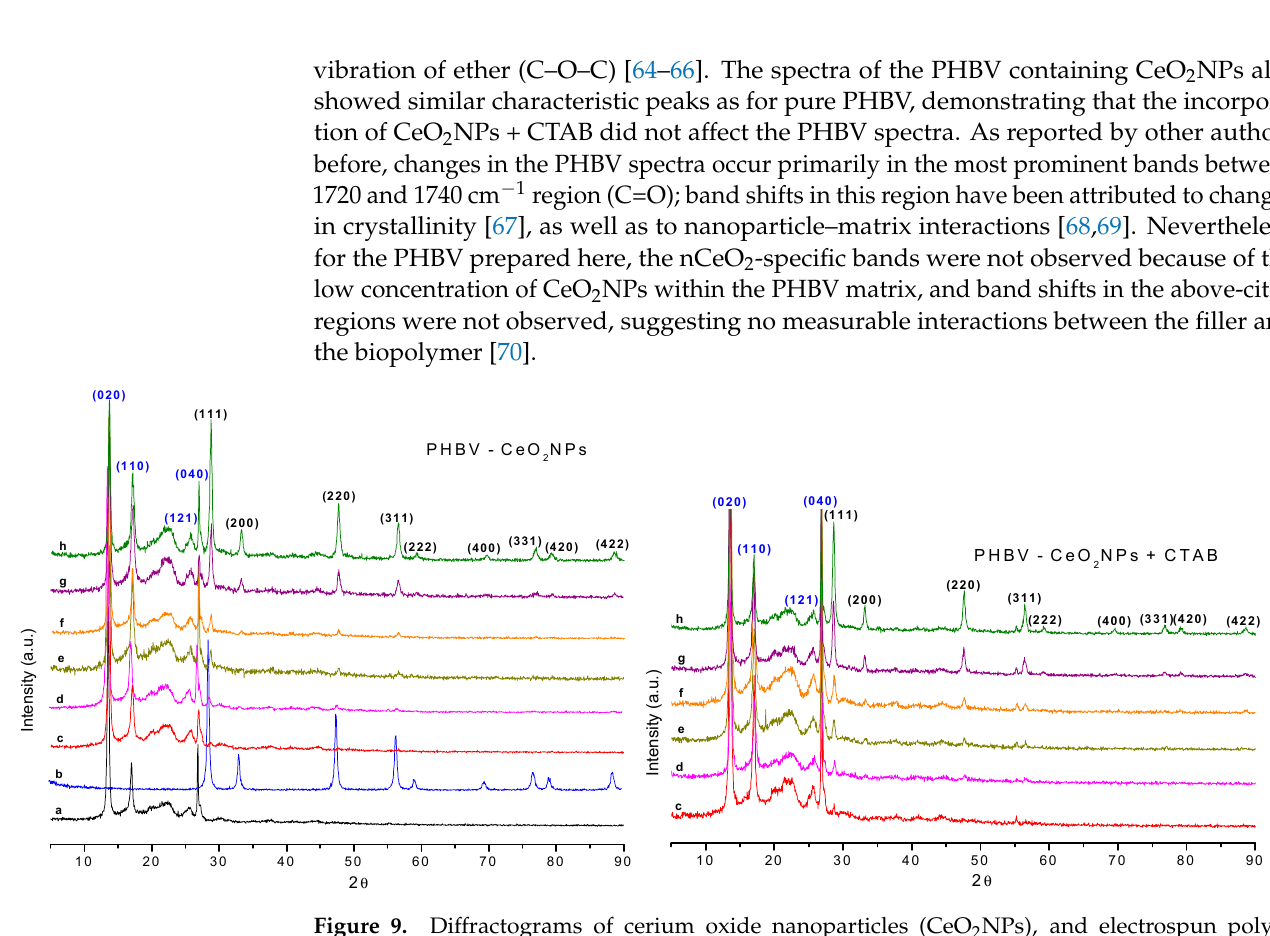
Figure 9. Diffractograms of cerium oxide nanoparticles (CeO 2 NPs), and electrospun poly(3-hydroxybutyrate-co-3-hydroxyvalerate) (PHBV) fibers loaded with CeO 2 NPs: ( a ) neat PHBV; ( b ) CeO 2 NPs; ( c ) 0.5 wt.% CeO 2 NPs; ( d ) 1.0 wt.% CeO 2 NPs; ( e ) 1.5 wt.% CeO 2 NPs; ( f ) 2.0 wt.% CeO 2 NPs; ( g ) 5.0 wt.% CeO 2 NPs; ( h ) 10.0 wt.% CeO 2 NPs.